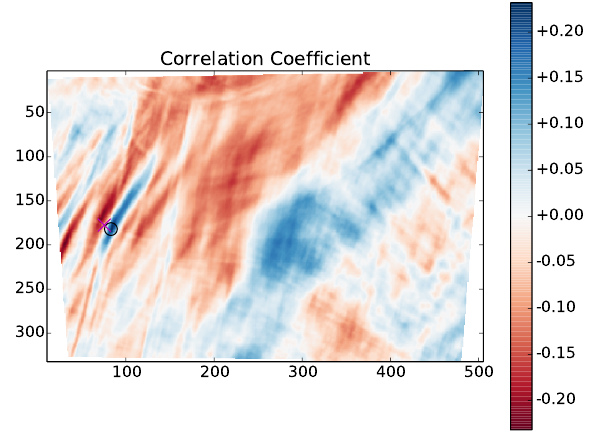
Figure 7: Correlation coefficients as in fig. 6, but for another ex- emplary UP, again with the maximum value marked by a black circle, being close to the correct position (magenta